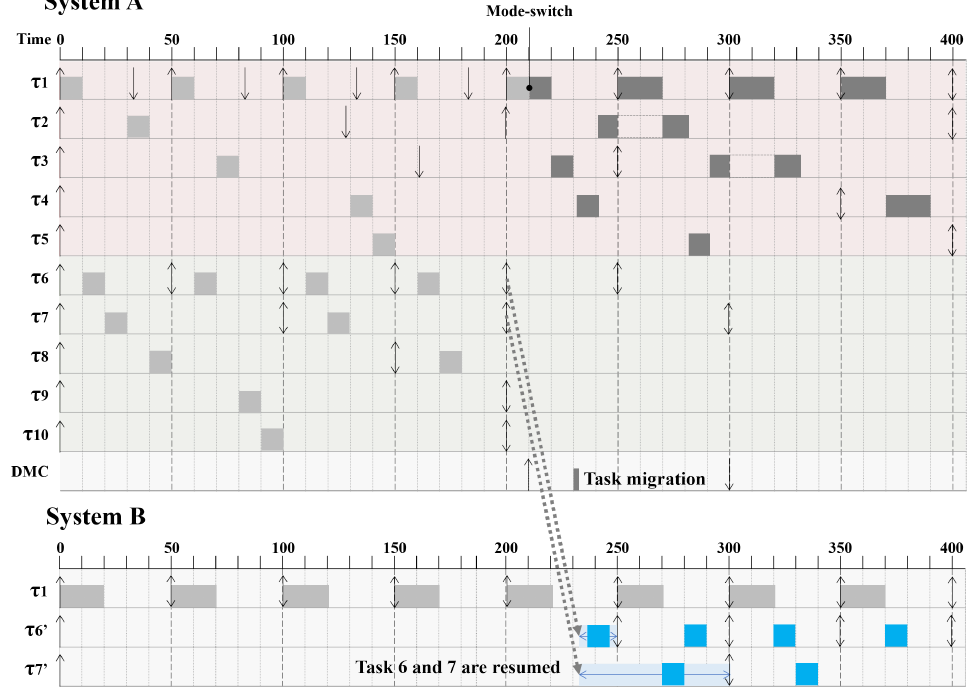
Figure 4. Gantt chart of